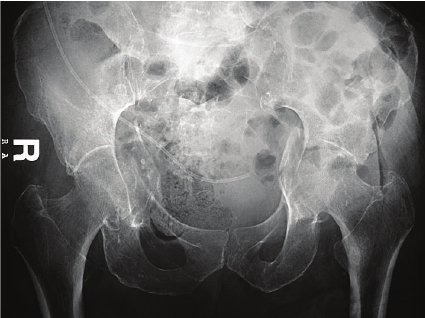
Figure 5: Acceptable hip congruity achieved following traction and formation of a callus with adequate healing of both